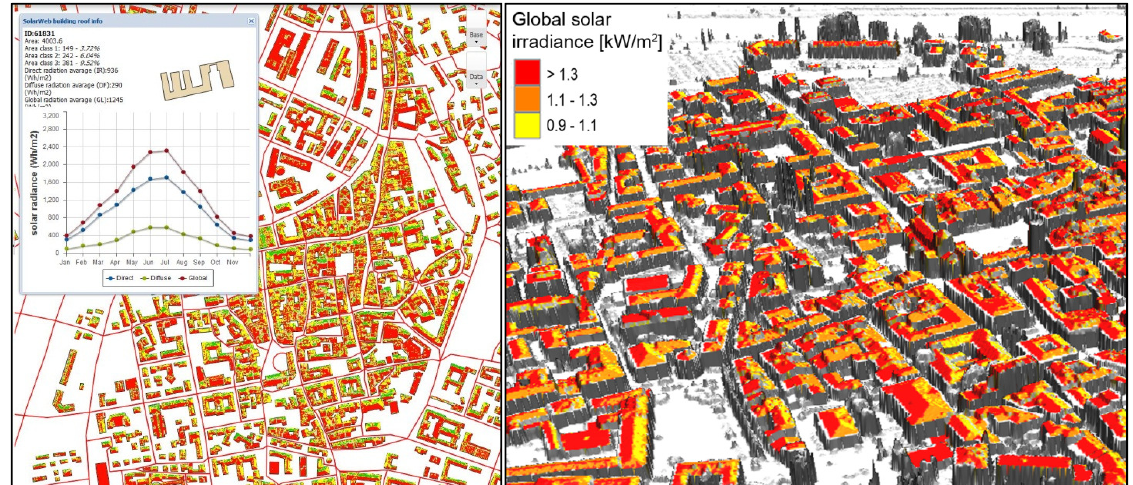
Figure 8: [Left] Screenshot from the WebGIS application with building footprints, the roofs classified according to the incoming global solar irradiance (yearly average values), and monthly statistics. [Right] 3D view of the study area showing the classified roofs mapped on top of the LiDAR